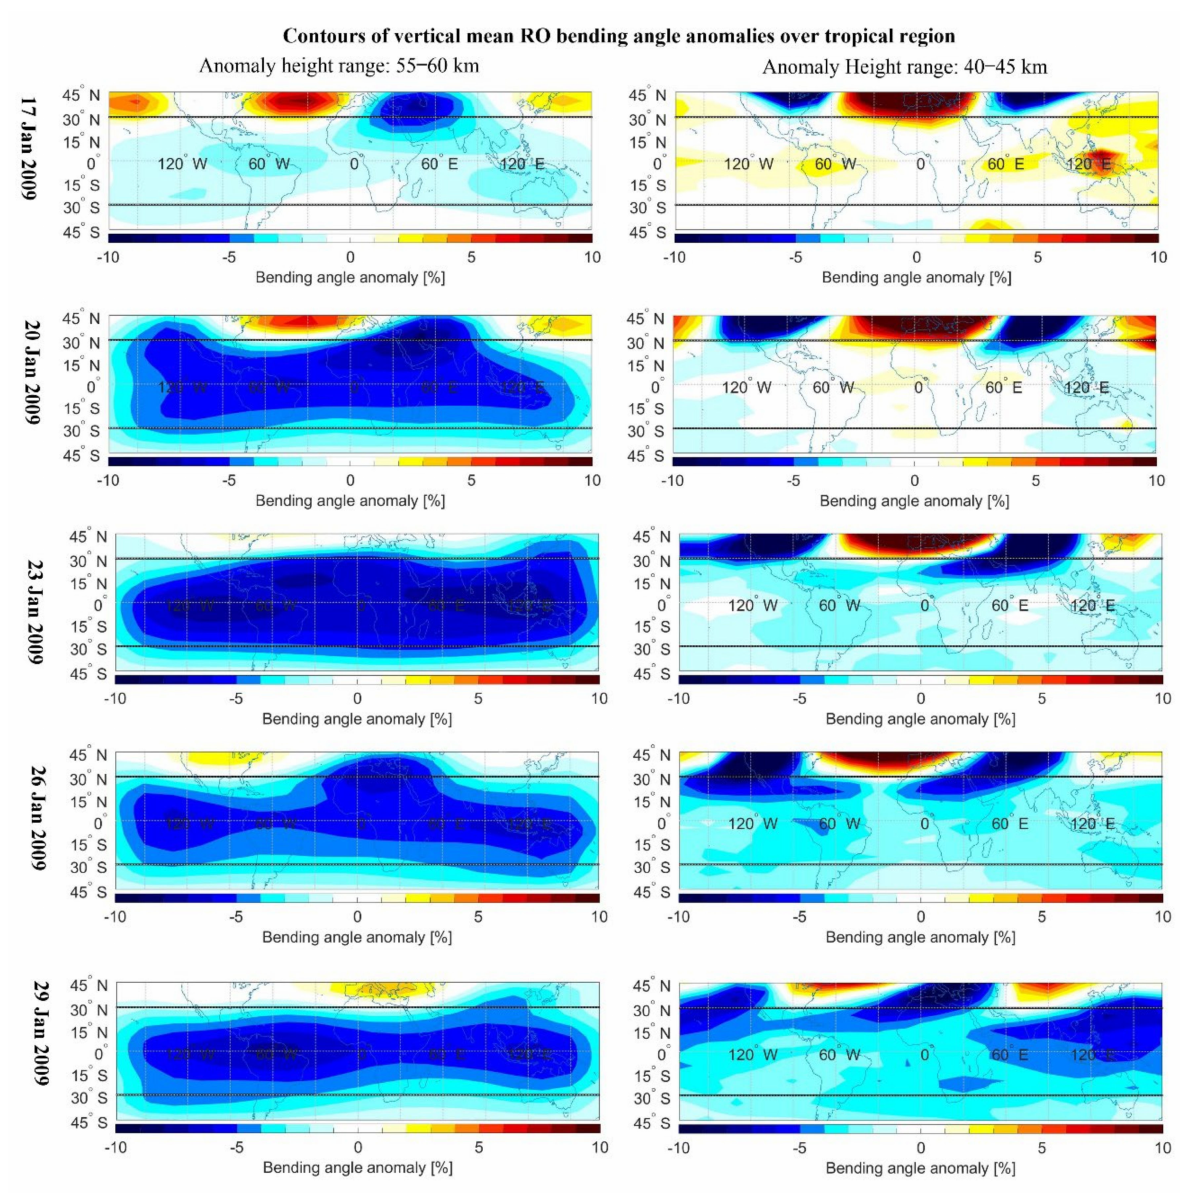
Figure 8. Latitude and longitude sectors of gridded mean RO bending angle anomalies obtained from response altitude layer 55–60 km (left panels) and from downward altitude layer 40–45 km (right panels) on five exemplary days of 17, 20, 23, 26, and 29 January